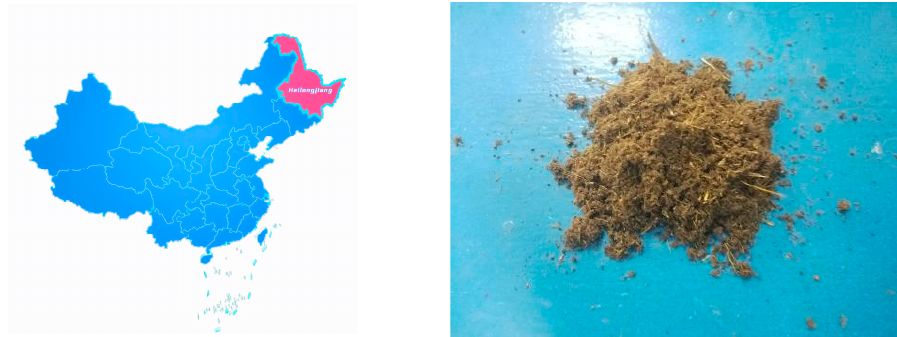
Figure 1. Experimental site and materials (Loose state of mixed straw after treatment).